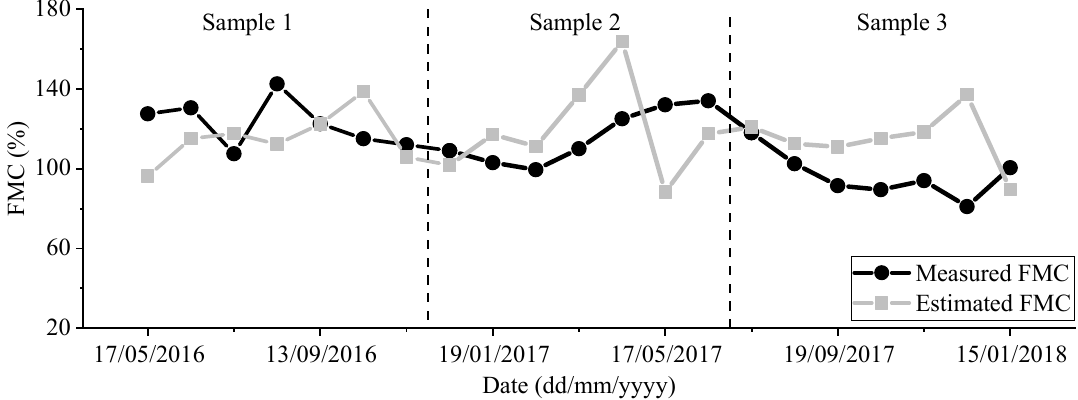
Figure 13. The time-series trend of estimated and measured FMC.